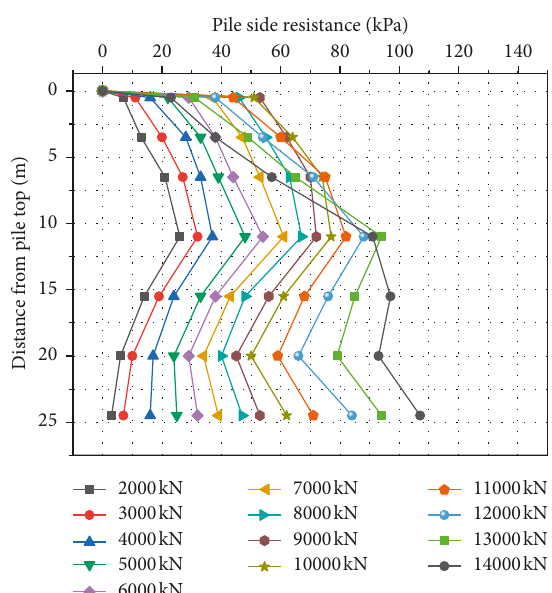
Figure 13: Pile side resistance of IDP.